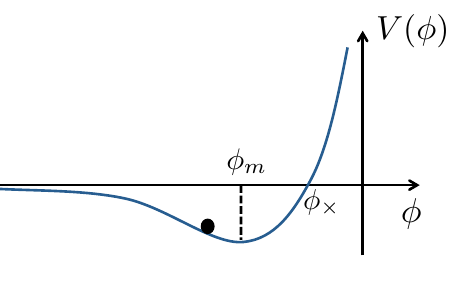
Figure 1 . A schematic form of the potential for a particle (cid:30) ( t